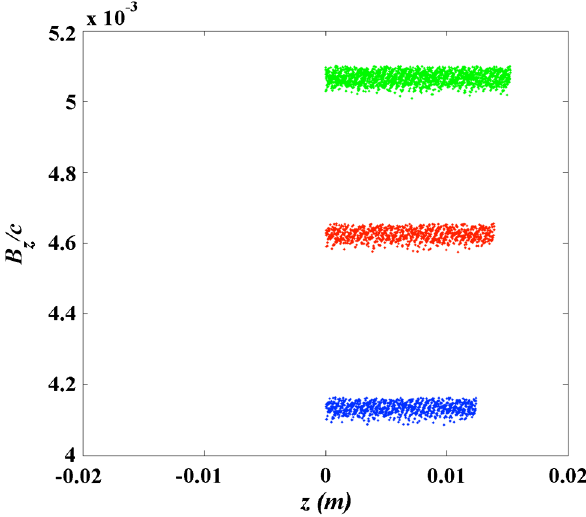
FIG. 30. Longitudinal velocities of C 6 þ (top), C 5 þ (middle), and C 4 þ (bottom) ions, immediately after the ECRIS. C 6 þ shows the highest kinetic energy applying the same extracting voltage, here 24 kV, to all